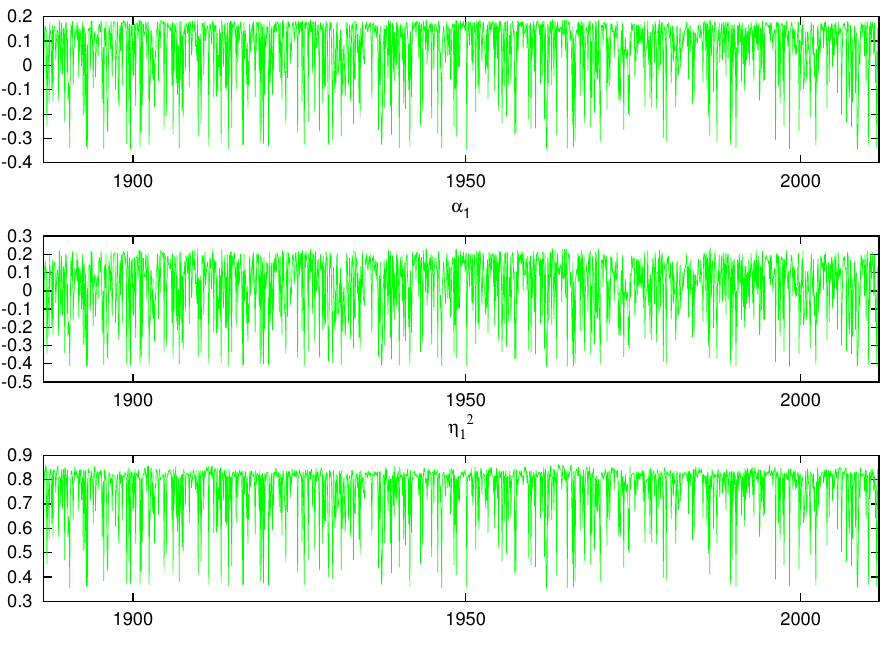
, α 1, s and η 2 1, s t t t